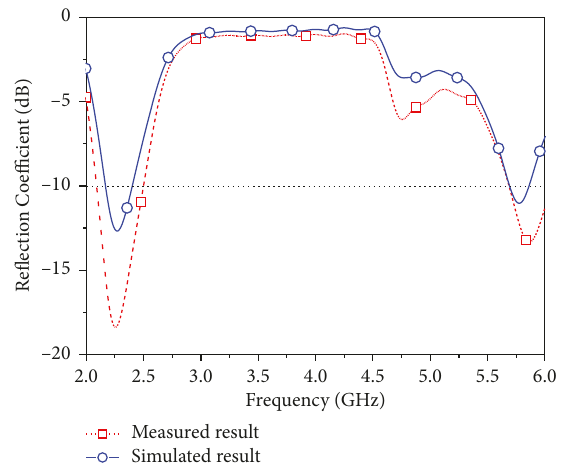
Figure 11: Measured and simulated reflection coefficient of the proposed